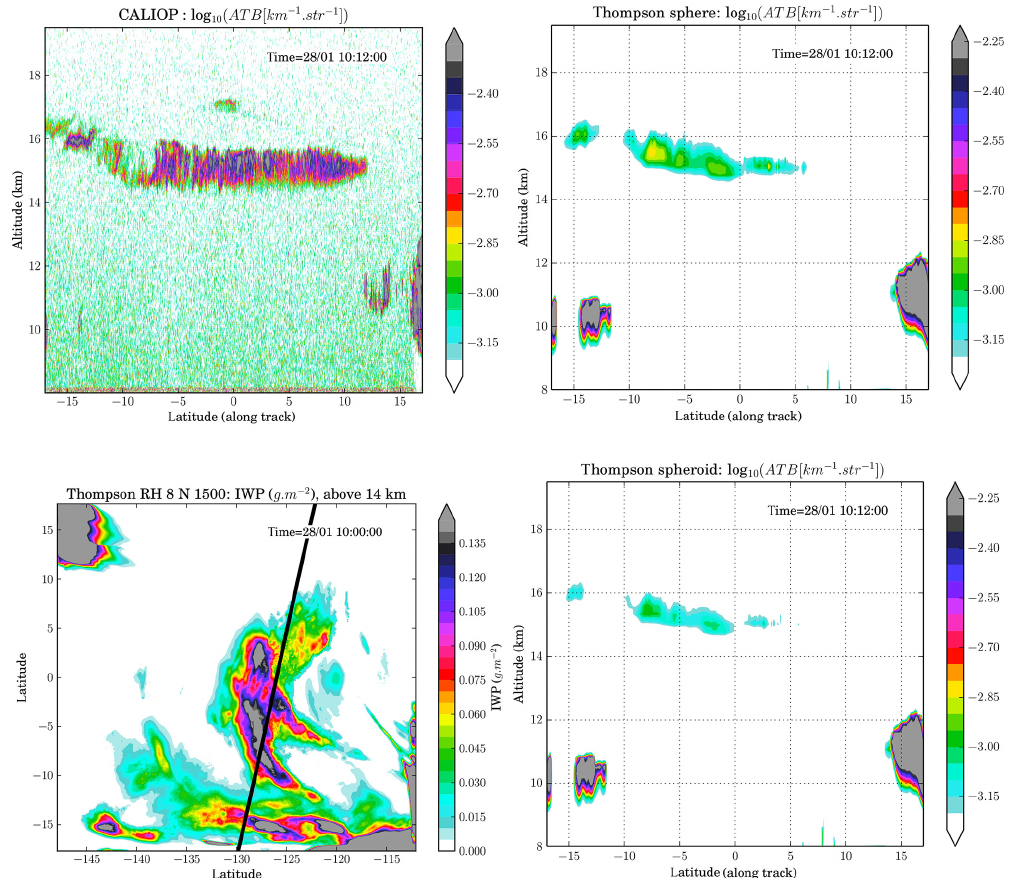
Figure 1. (Top two panels) Decimal logarithm of total attenuated backscatter (ATB) at 532nm, from (left) CALIOP observations and (right) WRF reference simulation, using default Thompson microphysics and assuming spherical ice crystals. ATB in the simulation assuming non spherical crystals is also shown (bottom right). (Bottom left panel): total ice water path above 14km in the reference simulation, at the time of CALIOP passage. The satellite track is highlighted by the black